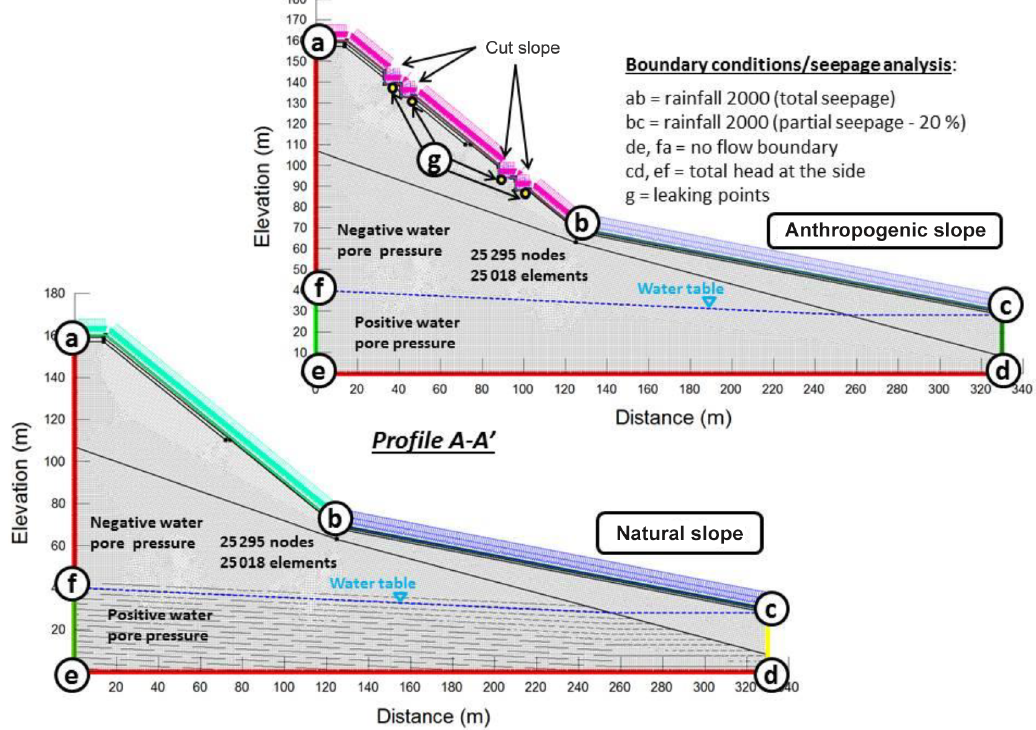
Figure 5. Slope geometry and boundary conditions used in the unsaturated transient seepage analysis with natural and anthropogenic factors (rainfall, cut slope and leakage). Table 2. Results of the geotechnical survey of soils of the study areas. Sample